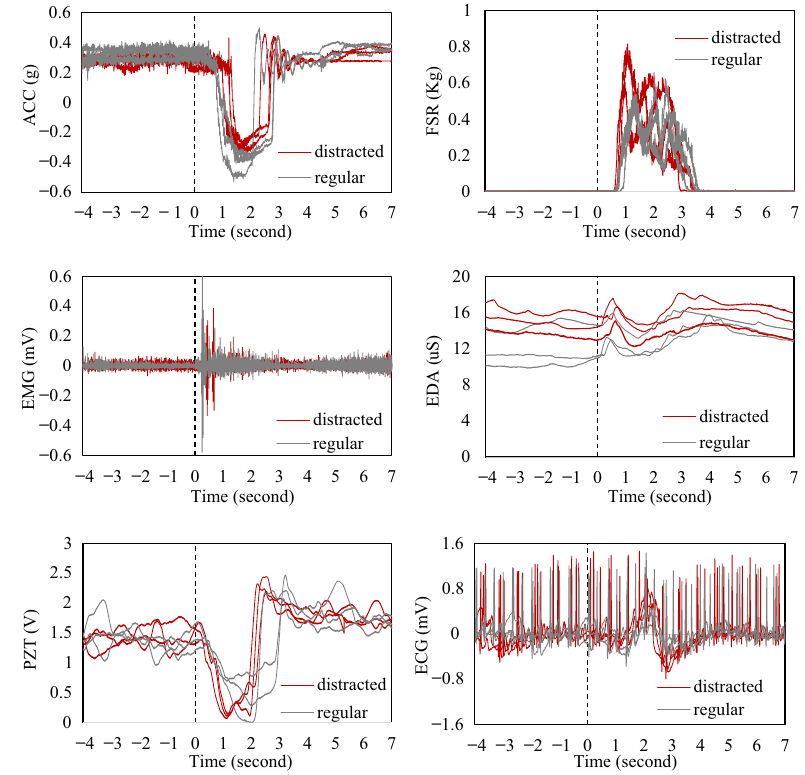
Figure 6 Physiological signal data in distracted and regular driving situations (Driver ID = 13)